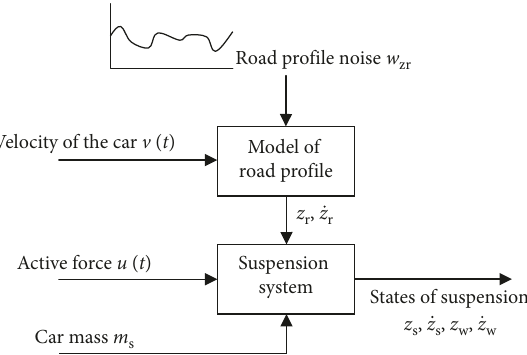
Figure 8: The model of the suspension systems taking into account the road profile and velocity of the car.